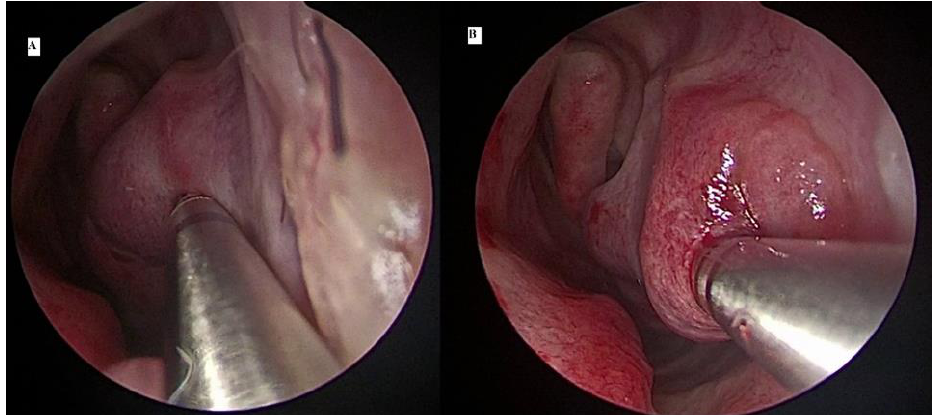
Figure 5. Radiofrequency probe is inserted at anterior head of the inferior turbinate and pushed in an anterior ( A ) to posterior ( B ) direction. an anterior ( A ) to posterior ( B )